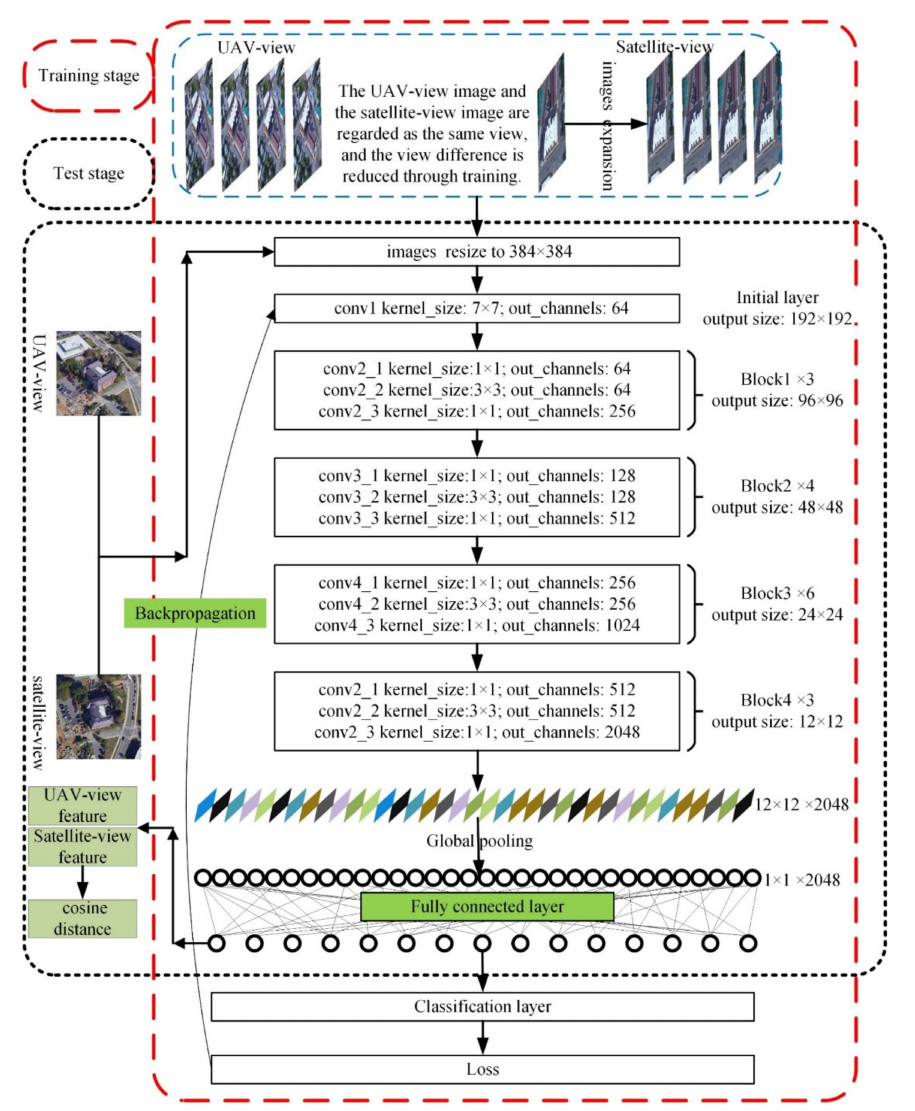
Figure 4. The cross-view matching method framework of UAV-view images and satellite-view images. Due to the limitation of figure size, we only show the key convolutional layers, newly added pooling layer, newly added fully connected layer, and newly added classification layer in the